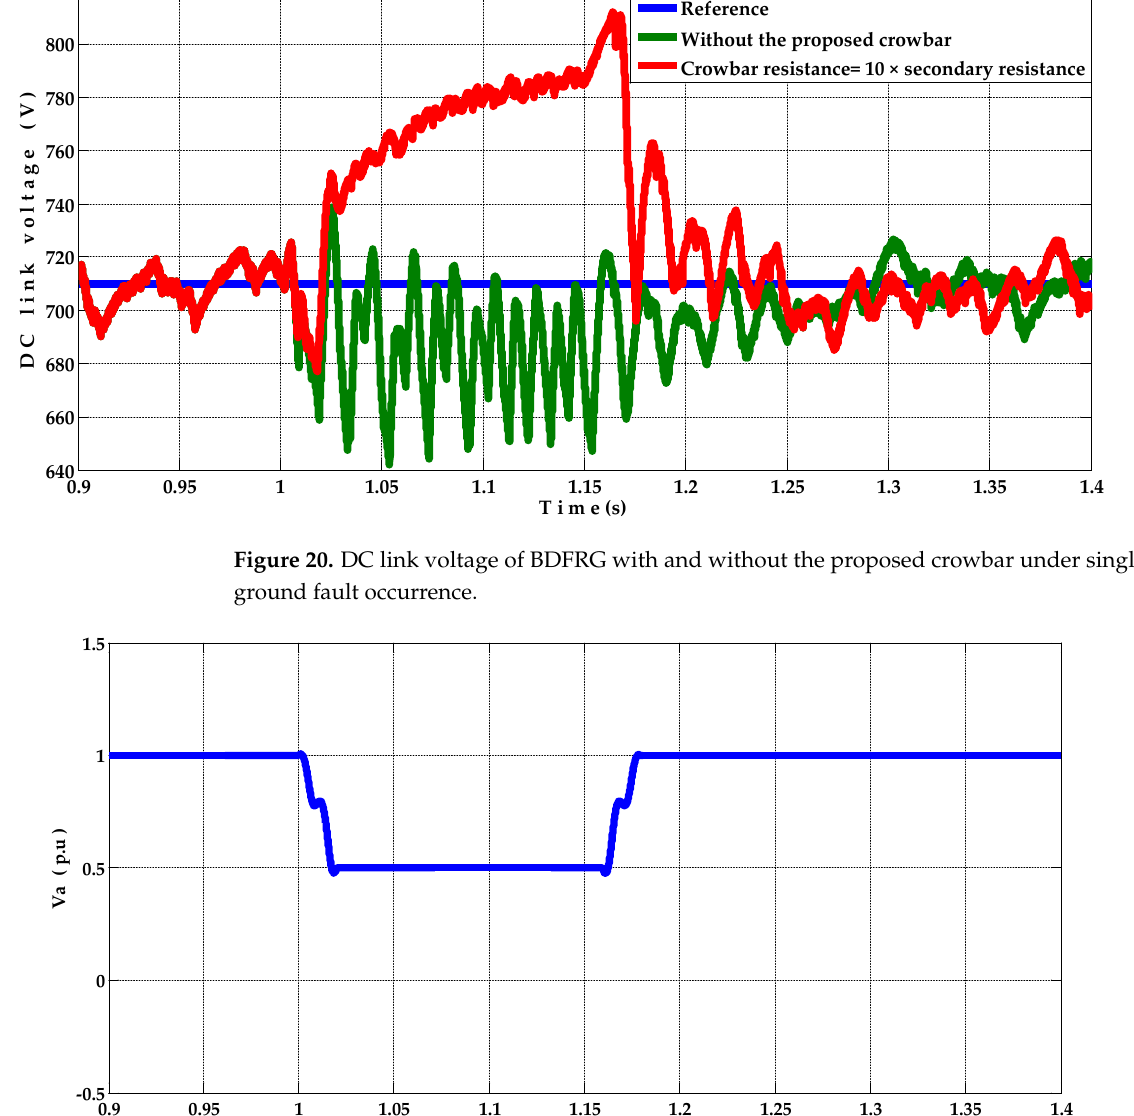
Figure 21. Per unit rms terminal voltage (Va) of the studied wind farm main coupling point under line to line fault occurrence.